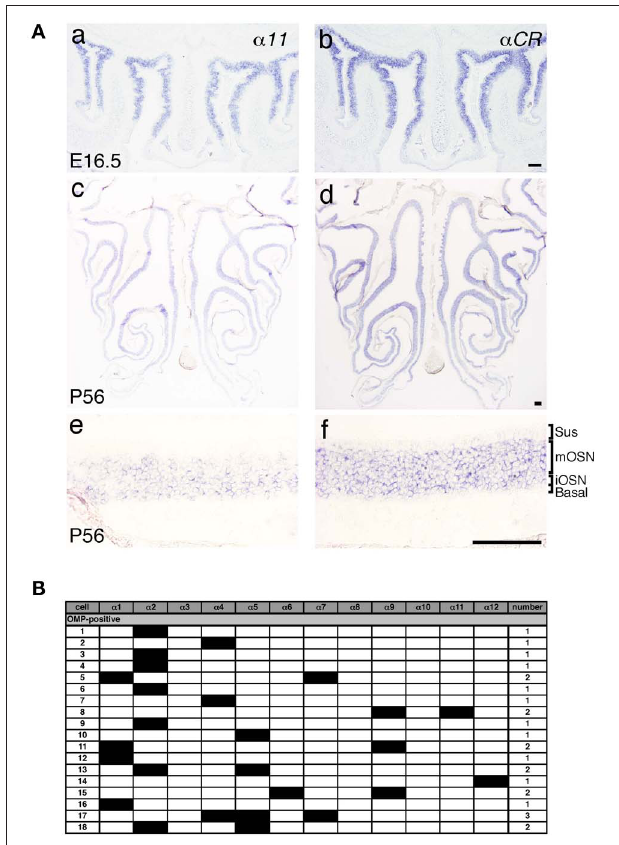
FIGURE 4 | Expression of Pcdh- α mRNAs in OSNs of the OE. (A) In situ hybridization histochemistry with an α 11 isoform-specific probe and a α CR probe for all the Pcdh- α isoforms at E16.5 (a, b) and P56 (c–f). High magnifications are shown in (e) and (f). Sus, sustentacular cell-body layer; mOSN, mature OSN cell-body layer; iOSN, immature OSN cell-body layer; Basal, basal cell body layer. Scale bars, 100 μ m. (B) Single cell RT-PCR analysis of individual OSNs using adult OMP-GFP